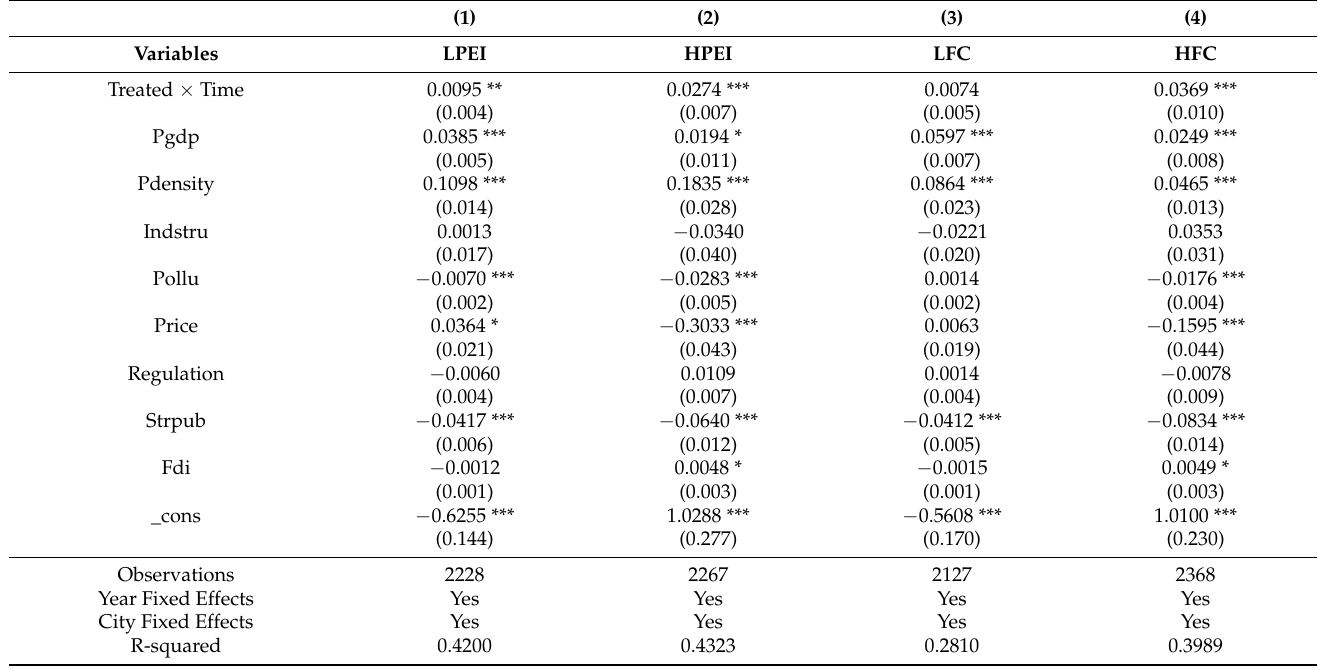
Table 8. Heterogeneity test: pollutant emission intensity and financing